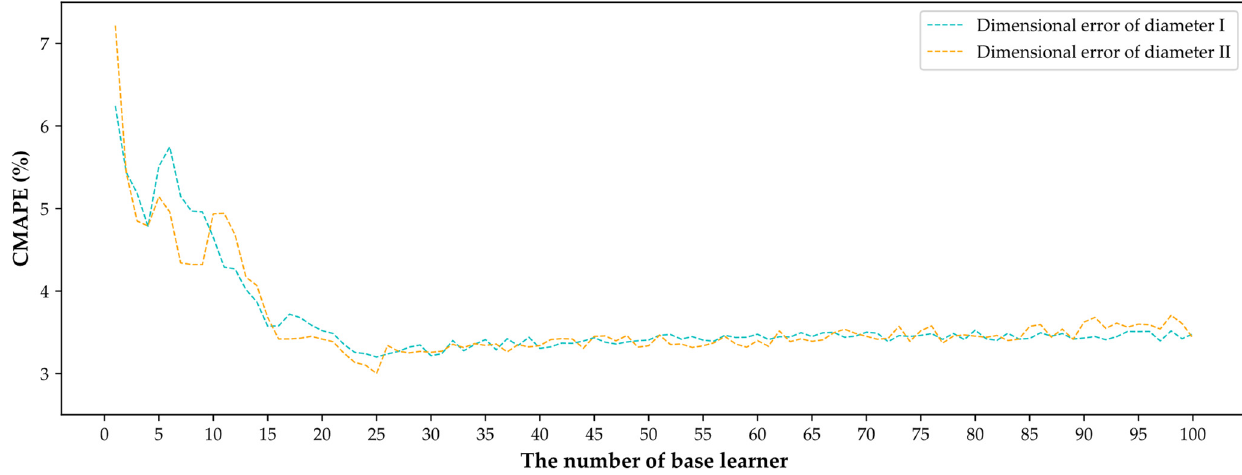
Figure 11. The prediction performance on the different number of base learners.